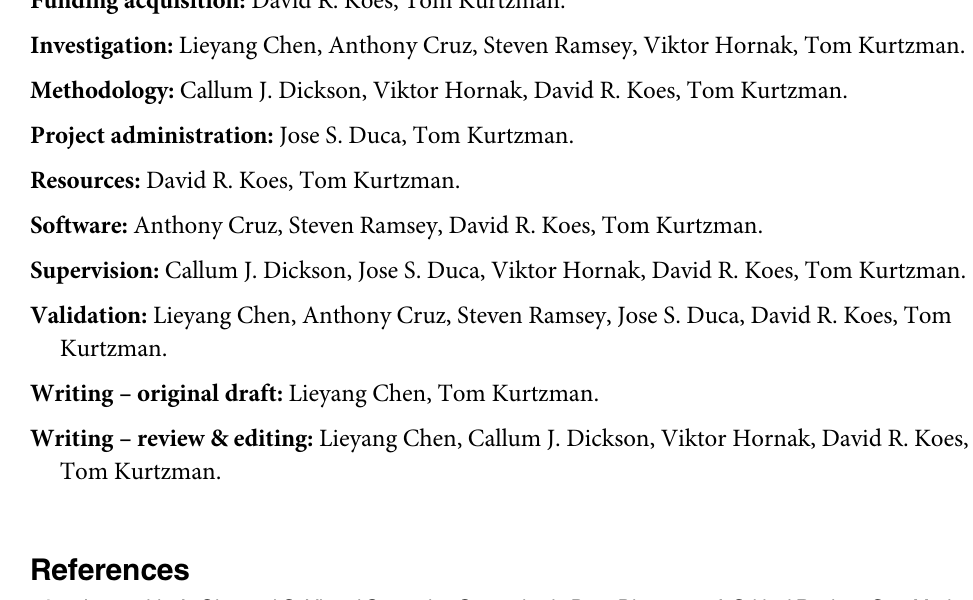
S2 Table. AUC values achieved by the ligand-only CNN models trained by a small number of actives/decoys for each target. Replication n = 3. S3 Table. AUC values for the 102 � 102 cross-target prediction by ligand-only CNN models tested on the DUD-E dataset. S4 Table. The ligand-only CNN models that achieved high AUC for TGRF1 and the func- tionality of the targets that the models were trained on. S5 Table. Active overlap among the 102 DUD-E targets. S6 Table. AUC values for the 102 � 102 cross-target prediction by ligand-only CNN models tested on the AD